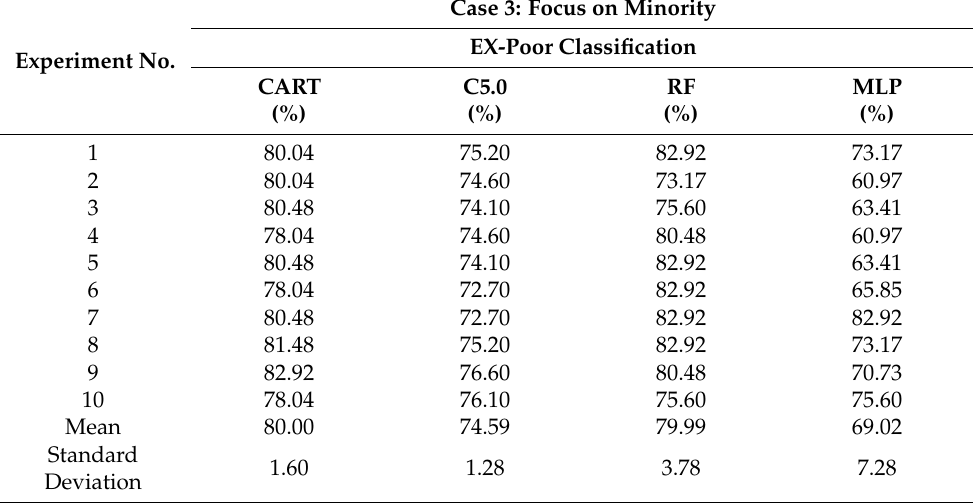
Table 5. Results of Case 3.